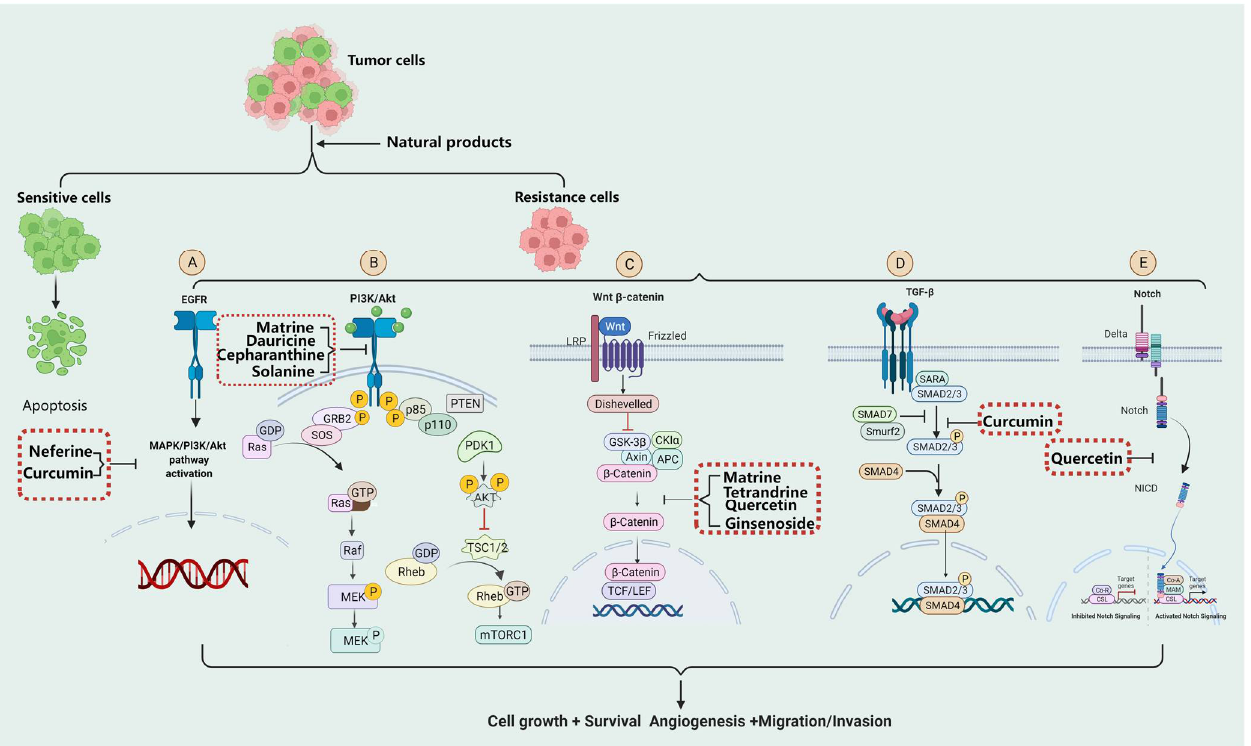
Figure 1. Molecular mechanisms of tumor drug resistance induced by EGFR, PI3K/Akt, Wnt/ β - catenin, TGF- β , and combinations of these signaling pathway inhibitors’ derivatives from natural products to overcome tumor resistance. ( A ) EGFR signaling pathway and its inhibitors’ derivatives from natural products. ( B ) PI3K/Akt signaling pathway and its inhibitors derivatives from natural products. ( C ) Wnt/ β -catenin signaling pathway and its inhibitors’ derivatives from natural products. ( D )TGF- β signaling pathway and its inhibitors’ derivatives from natural products. ( E ) Notch signaling pathway and its inhibitors’ derivatives from natural